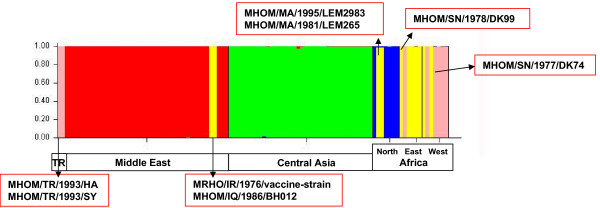
Population structure as shown by plots of Q (estimated membership coefficient for each sample), using five populations pre-defined according to their geographical origin. Regions may have more than one colour. For instance, strains from Iran and Iraq geographically belong to ME but genetically to East Africa as represented by the colour yellow.